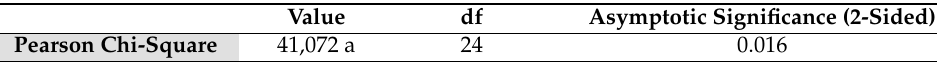
Table 25. Chi-square